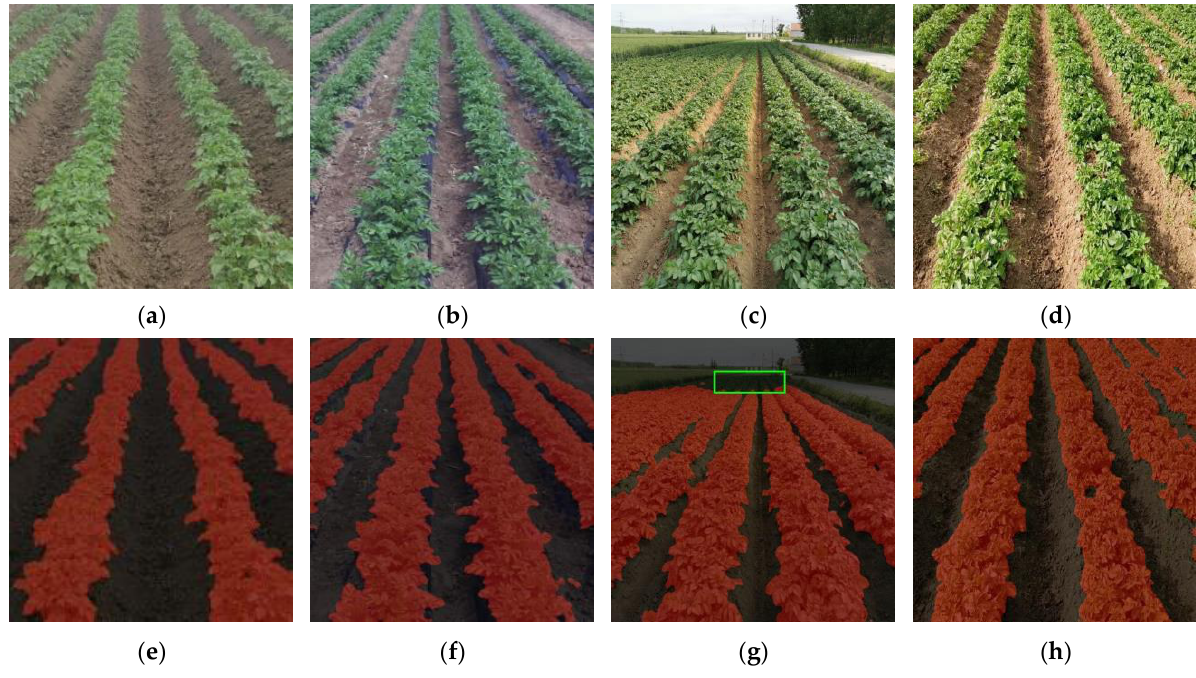
Figure 10. Potato segmentation results in different growth periods: ( a – d ) are the RGB images ( e – h ) are the corresponding segmentation results. The green anchor box is the part of the distant shadow interference that is not correctly segmented. Table 3. Comparison of segmentation accuracy under different working